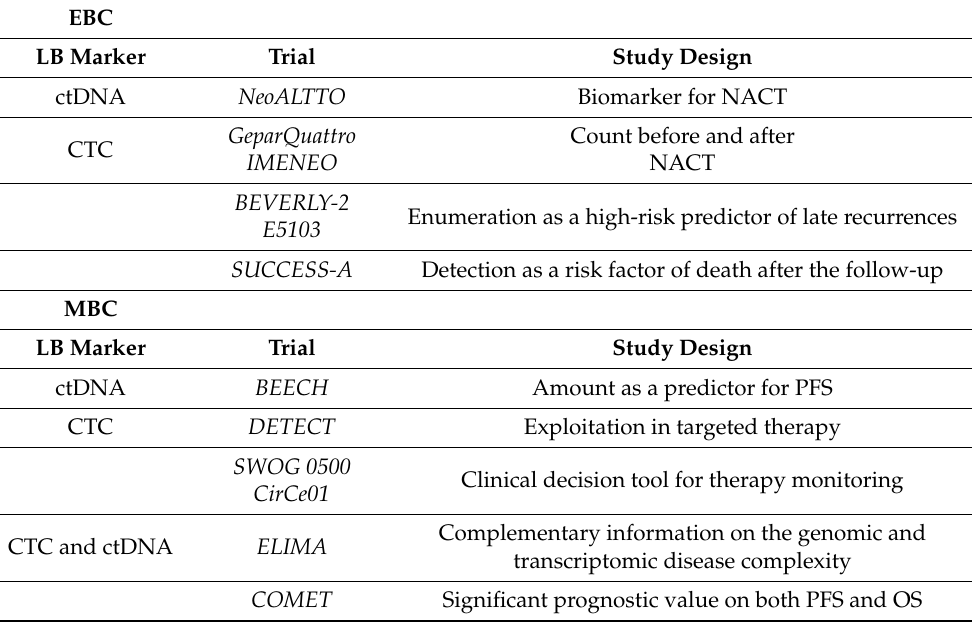
Table 1. List of the mentioned clinical trials. A search for the name of the trial provides additional information at www.clinicaltrials.gov (accessed on 31 January